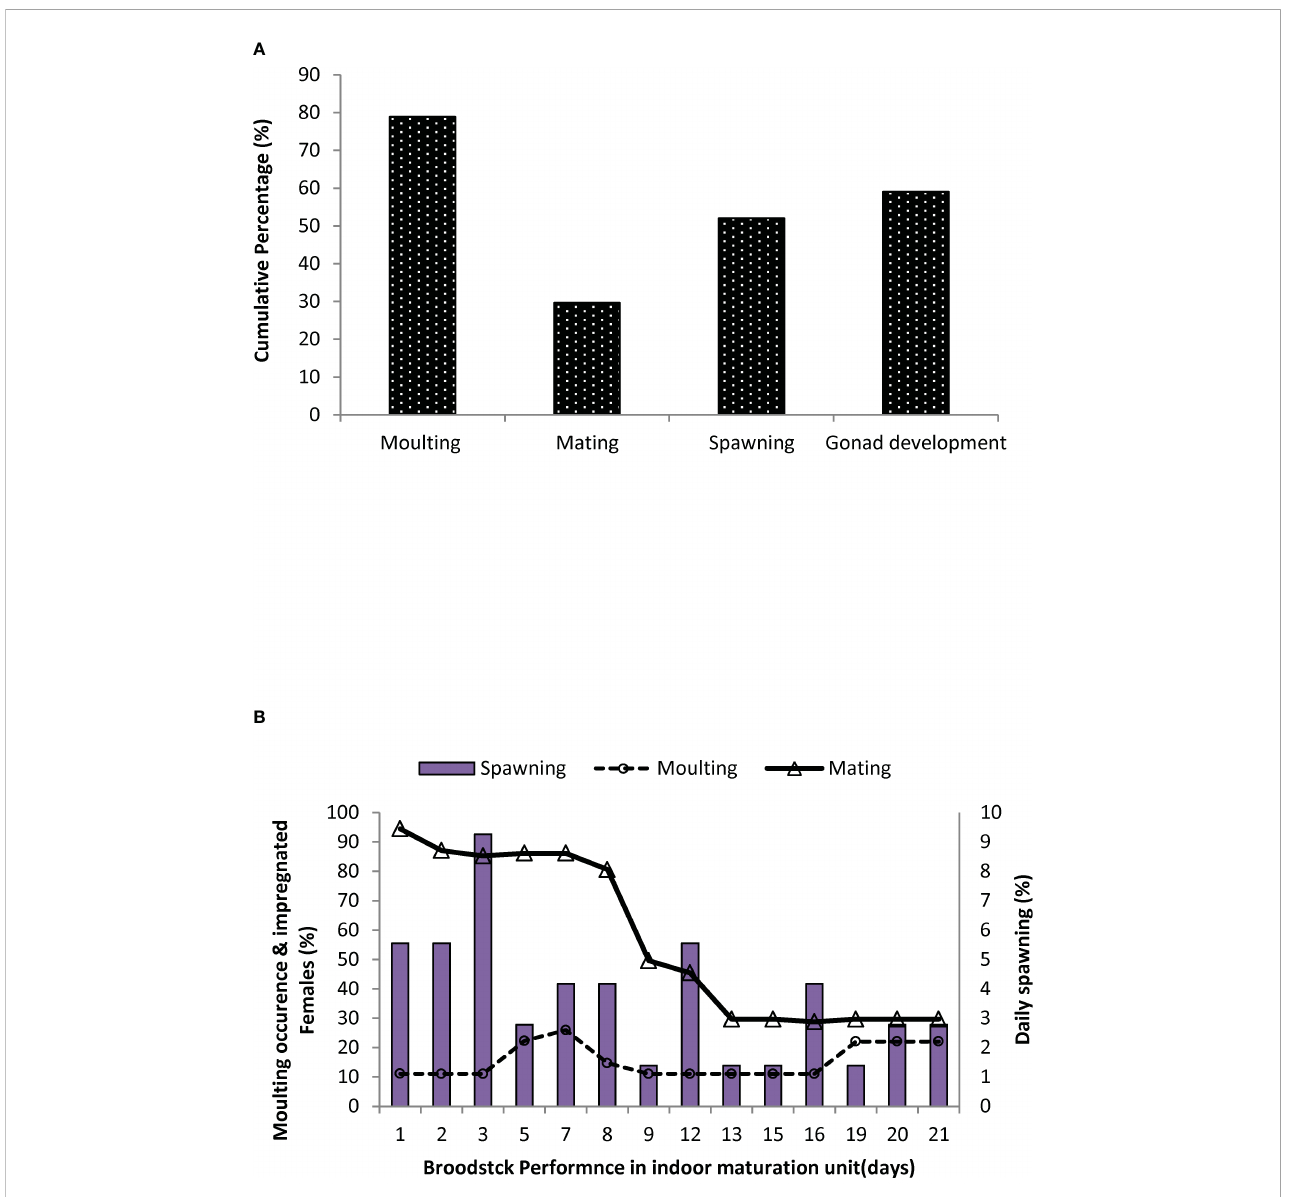
FIGURE 9 Reproductive performance of Penaeus indicus after eye-stalk ablation in indoor maturation cycle in Trial II. (A) Cumulative percentage of mating, moulting, spawning, and advanced gonad development in Penaeus indicus after eye-stalk ablation (B) . Daily percentage of mating, moulting, and spawning of captive-reared Penaeus indicus broodstocks after eye-stalk ablation.